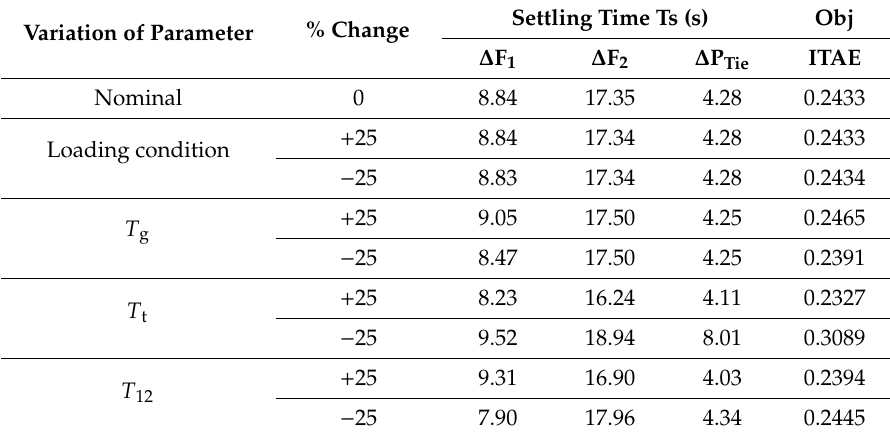
Table 5. Performance index values under system parameter